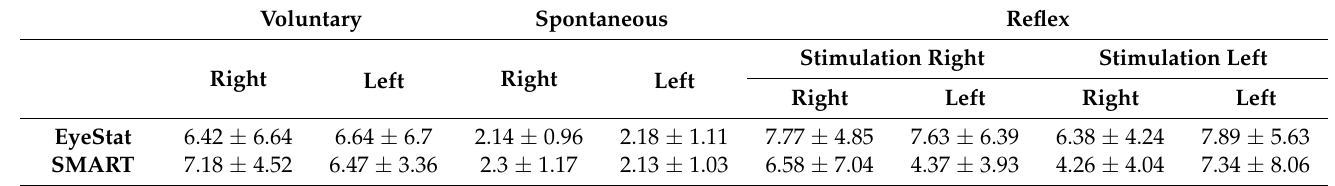
Table 1. Orbicularis oculi muscle electromyographic recordings. Electromyographic (EMG) record- ings are expressed in mV*ms. Data are indicated by mean ± standard deviation of the mean.